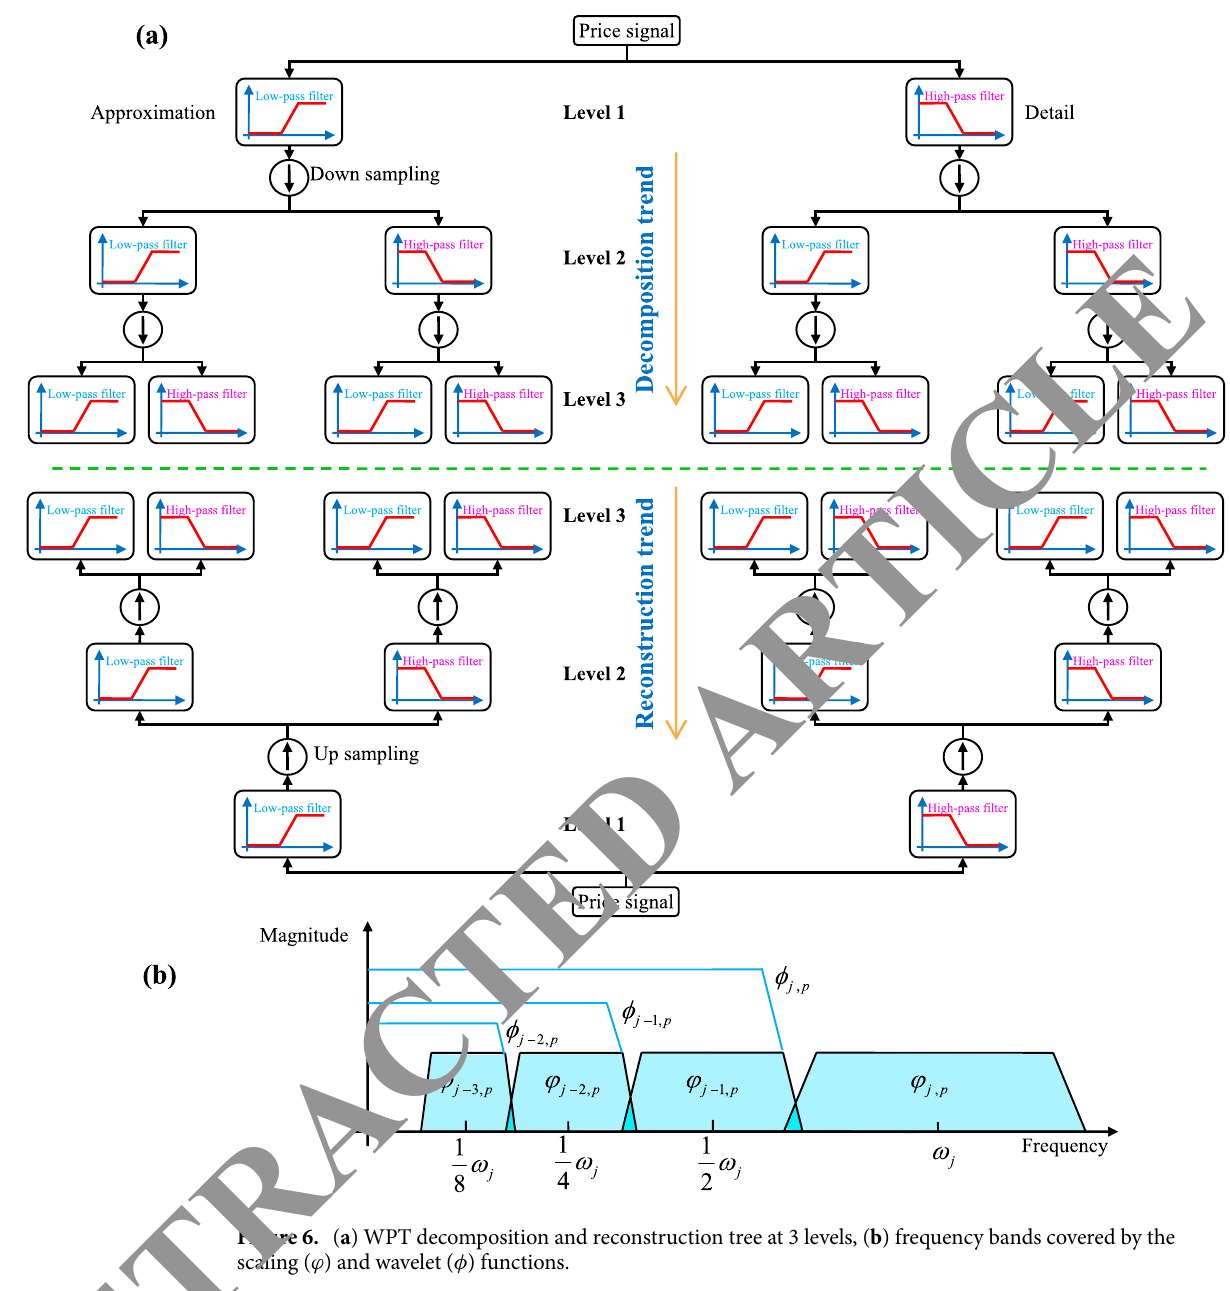
Figure 6. ( a ) WPT decomposition and reconstruction tree at 3 levels, ( b ) frequency bands covered by the scaling ( ϕ ) and wavelet ( φ )